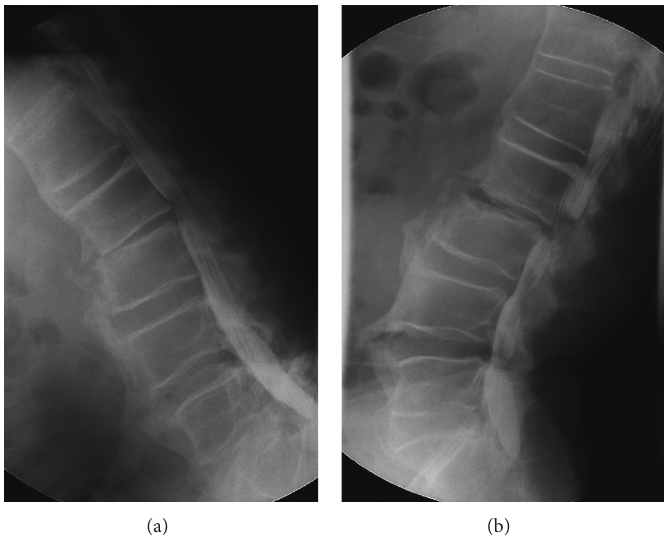
Figure 2: (a) Flexion and (b) extension images of the spine, showing instability at the L2-L3 intervertebral space and a stenosis of spinal canal is observed in the extension